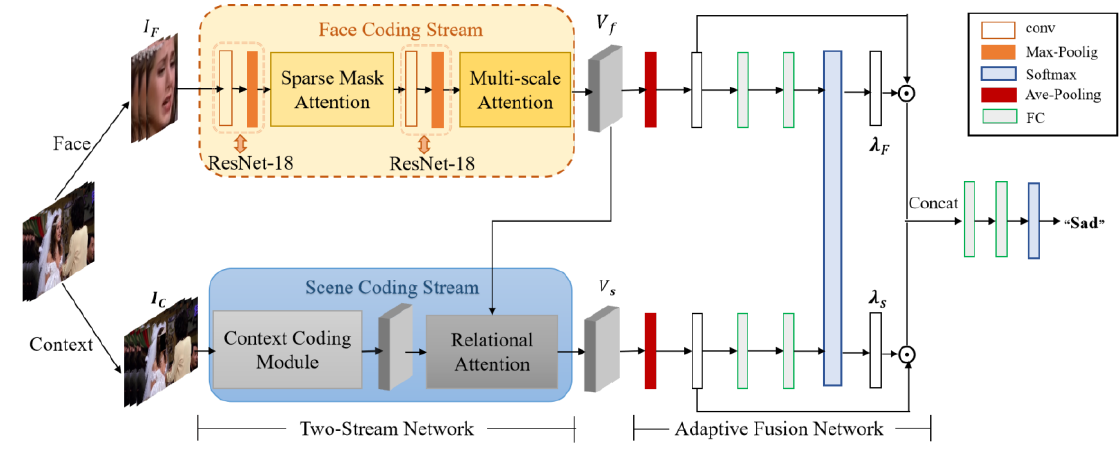
Figure 1. The architecture of our proposed method.